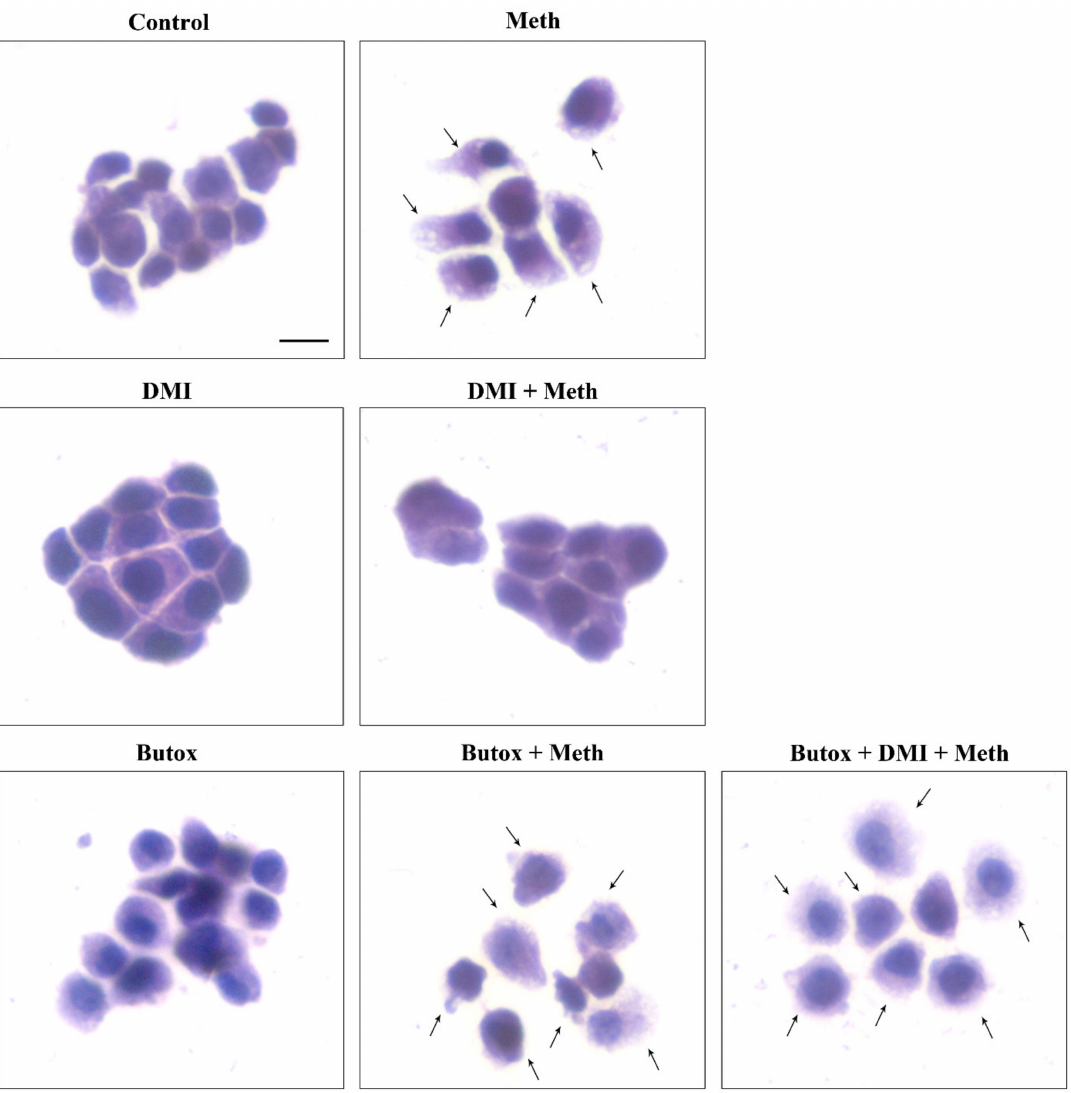
Figure 8. The NET blocker DMI protects against Meth toxicity through β 2-AR (H&E). Representative pictures show that the NET inhibitor DMI (100 nM) protects against Meth (50 µ M)-induced toxicity. This NET blocker is no longer protecting when the selective β 2-AR antagonist (butoxamine) is administered. Butoxamine (10 µ M) does not alter cell viability. Arrows indicate pale eosinophilic cells. Scale bar = 8 µ